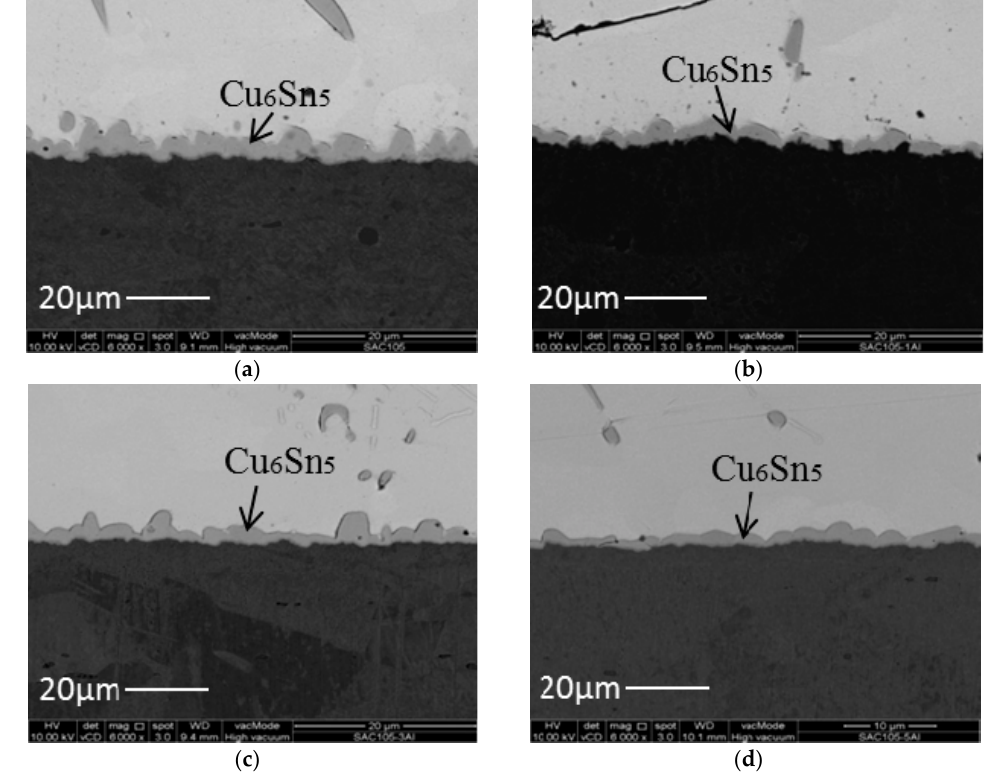
Figure 6. Cross sectional FESEM micrographs of: ( a ) SAC105; ( b ) SAC105 + 0.1Al; ( c ) SAC105 + 0.3Al; and ( d ) SAC105 + 0.5Al after 1 × reflow.